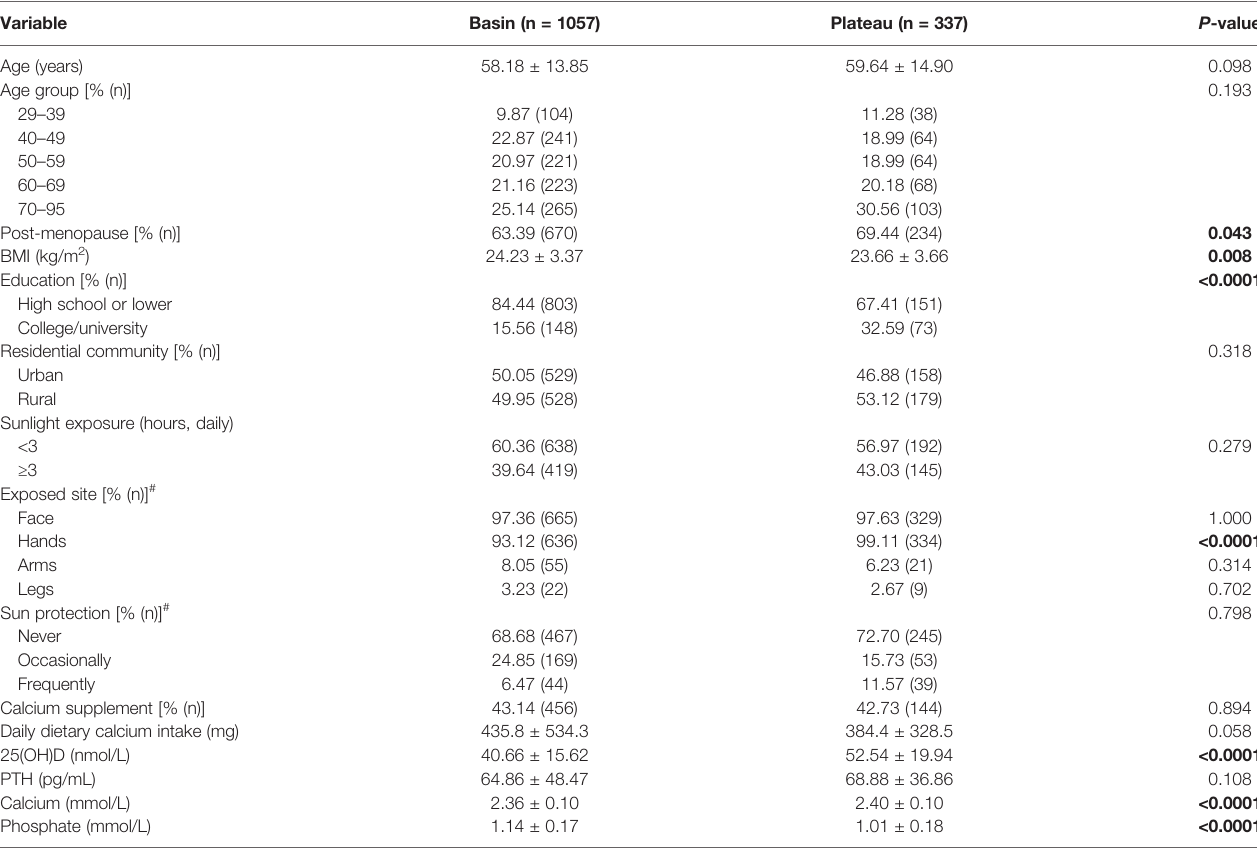
TABLE 1 | Characteristics of participants in basin and